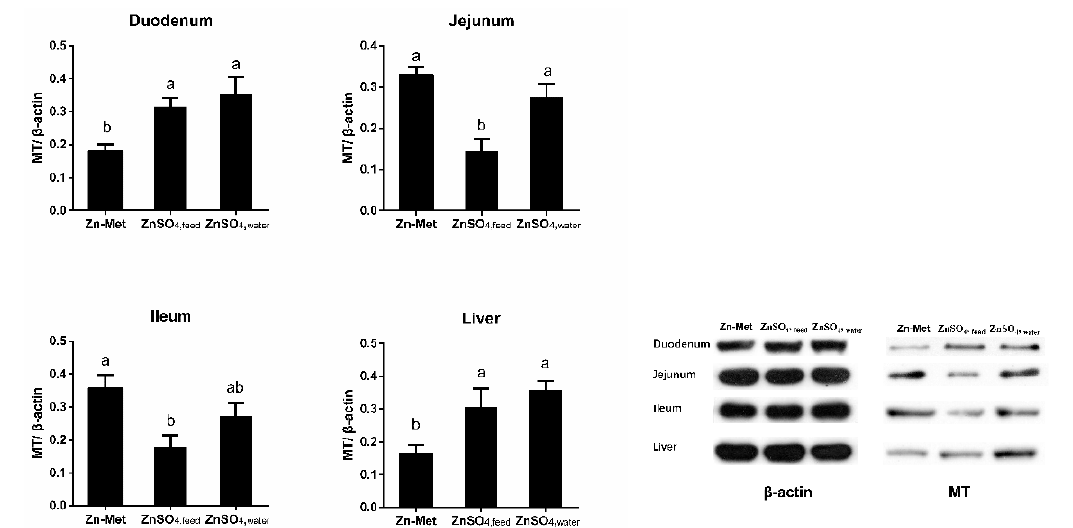
Figure 2. Effect of different Zn supplementation forms on MT protein levels in the duodenum, jejunum, ileum, and liver of the piglets. a, b: different letters were significantly different among groups ( p < 0.05).